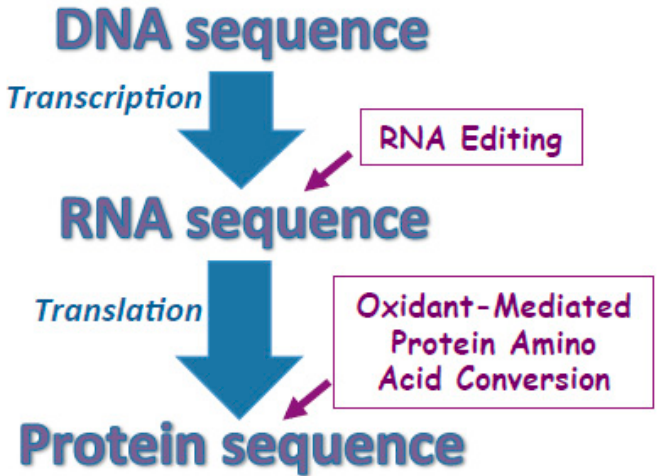
Figure 4. Proposed mechanisms for defining protein amino acid sequences. Protein amino acid sequences are largely defined by the sequence of DNA that is transcribed to mRNA then translated to the protein sequence. In some cases, RNA editing changes the sequence of mRNA thereby altering the protein amino acid sequence not to encode the DNA sequence completely. I proposed that the amino acid sequences can also be altered post-translationally through the oxidant-mediated protein amino acid conversions.